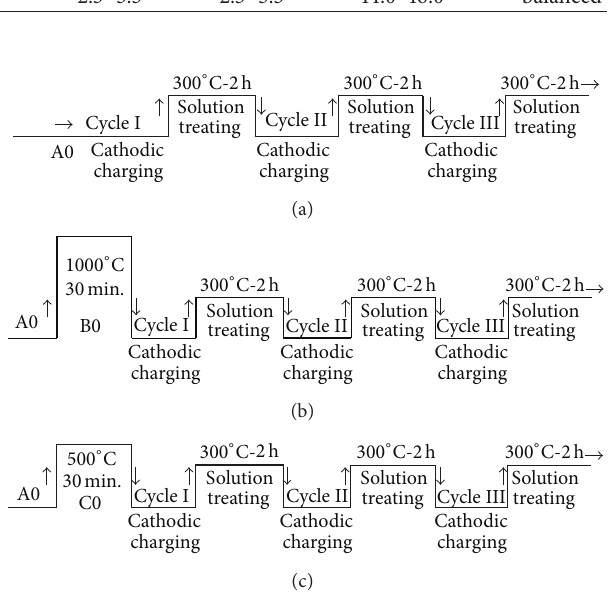
at 𝛼 phase region resulted in slight 𝛼 phase formation and